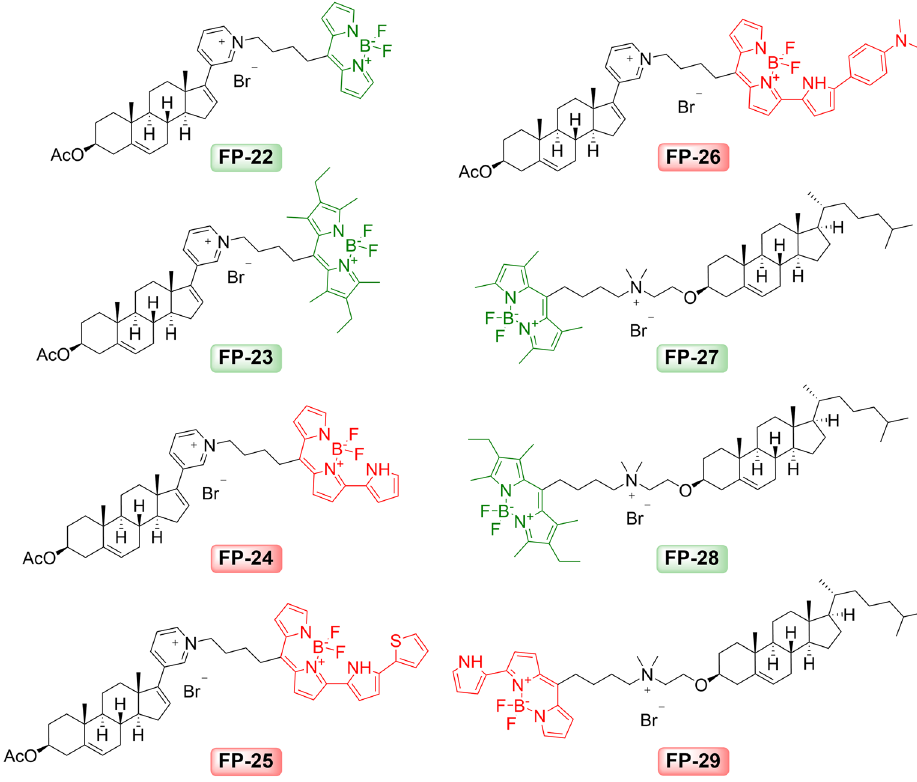
Figure 4. Sterol probes FP-22–FP-29 with various BODIPY dyes derived from P1 and P2